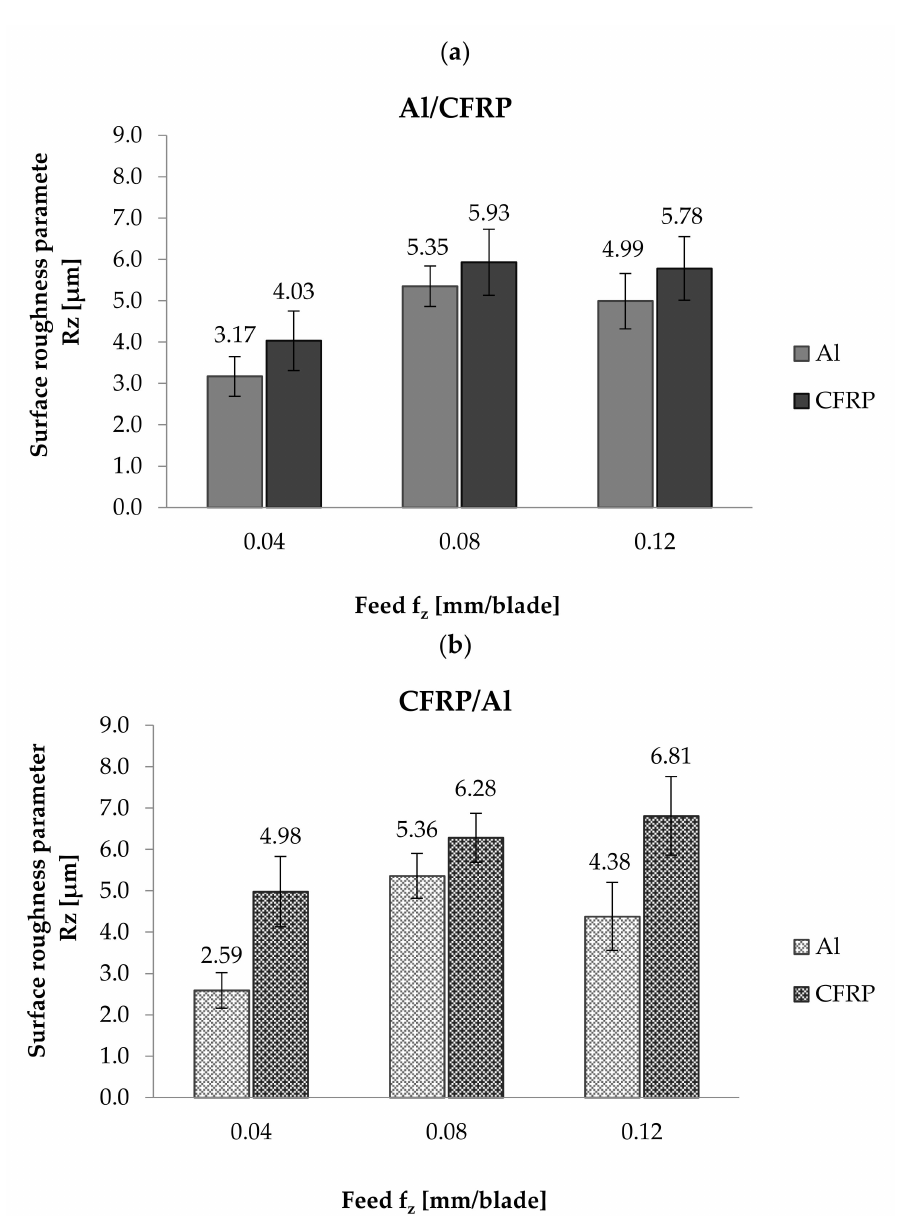
Figure 6. Rz parameter measurement results after milling: ( a ) using Al/CFRP strategy, ( b ) using CFRP/Al